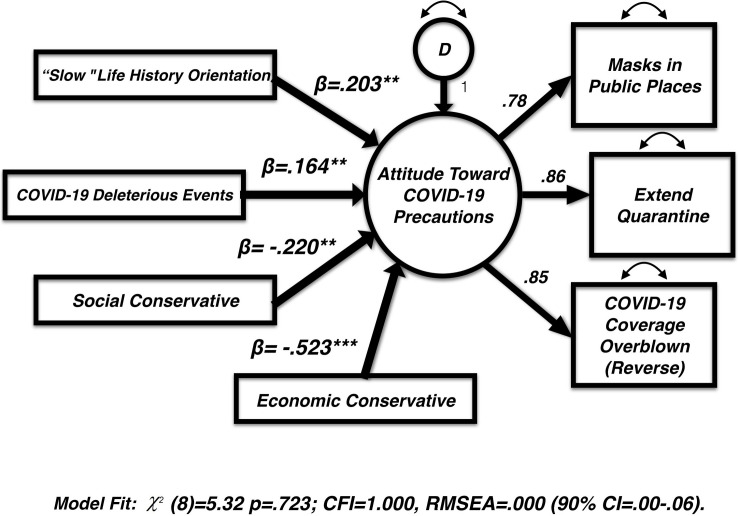
Final hybrid structural equation model including only variables retained. All endogenous (predictor) variables are modeled to covary with one another. Full covariate parameters are found on Table 1.